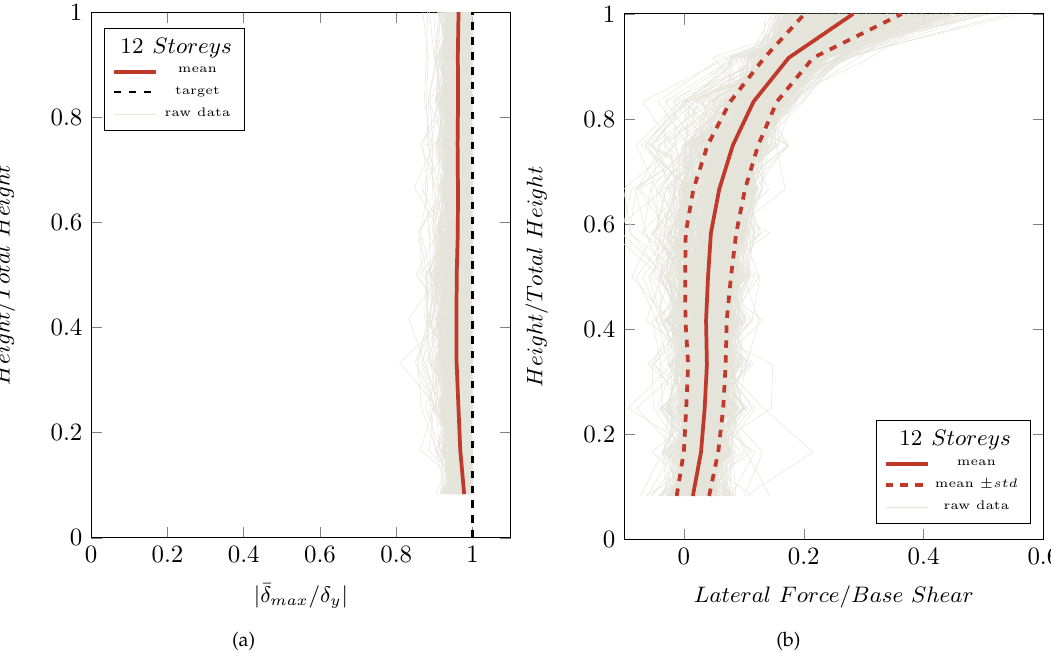
Figure 7. ( a ) Maximum dimensionless inter-storey displacement patterns for the 942 ground motions on the 12-storey SBM obtained from the GA proposed procedure. ( b ) Obtained lateral force